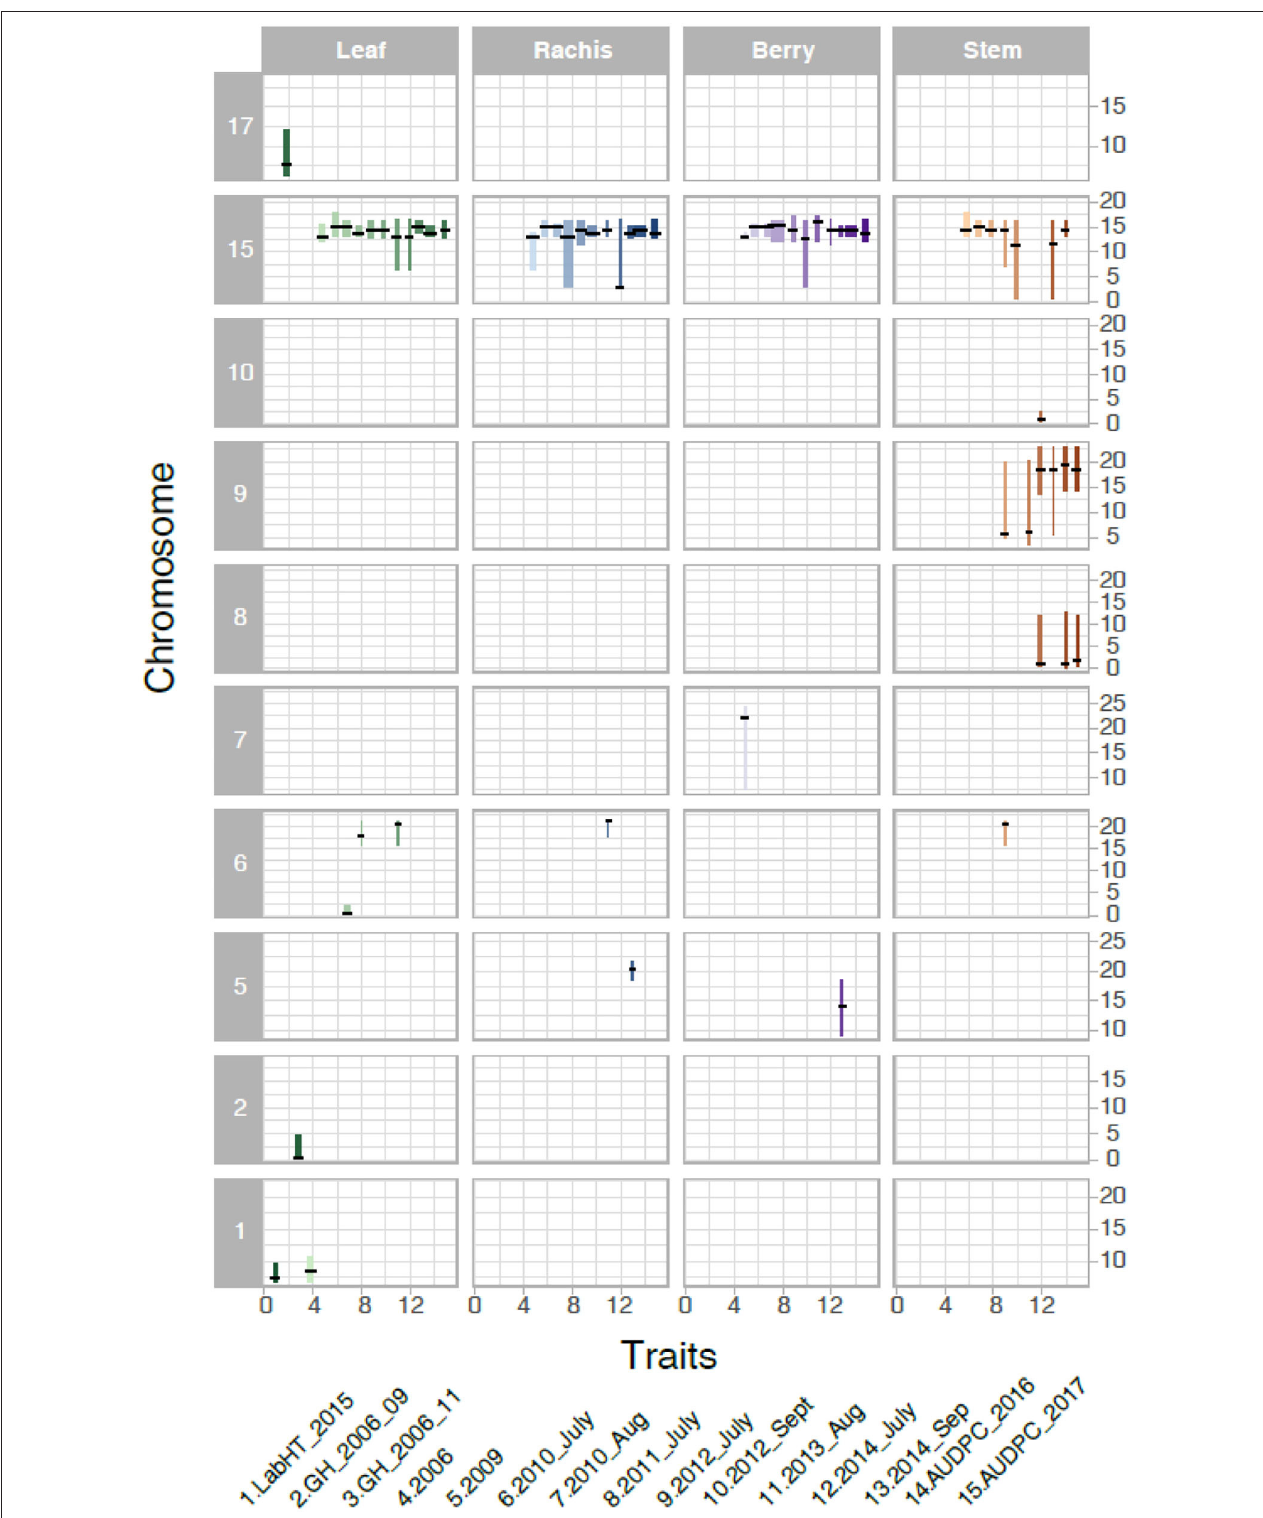
FIGURE 3 | Significant Quantitative trait locus (QTL) for powdery mildew severity by tissue in B37-28 × C56-11. The 15 powdery mildew traits (or environments) analyzed correspond to numbers on the x-axis, with traits 4–13 corresponding to vineyard disease ratings on a 1–4 scale. The vertical interval of each line shows the chromosome Mbp region of the QTL, with a crosshatch at the QTL peak. The thickness of the line indicates the percent variance explained by the peak marker.